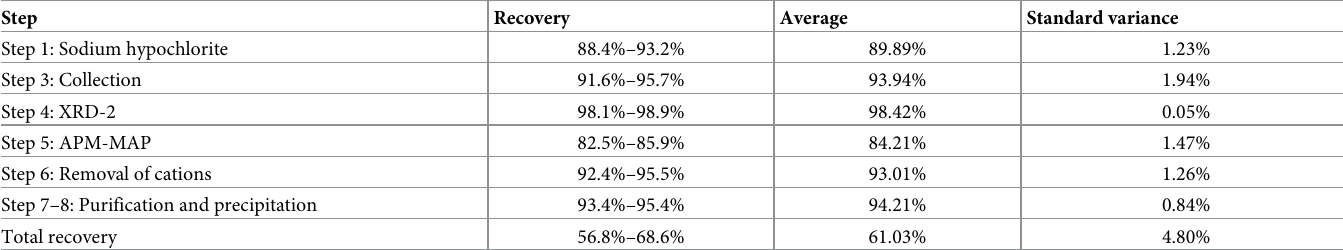
Table 4. Recovery of phosphate (sample size: n =